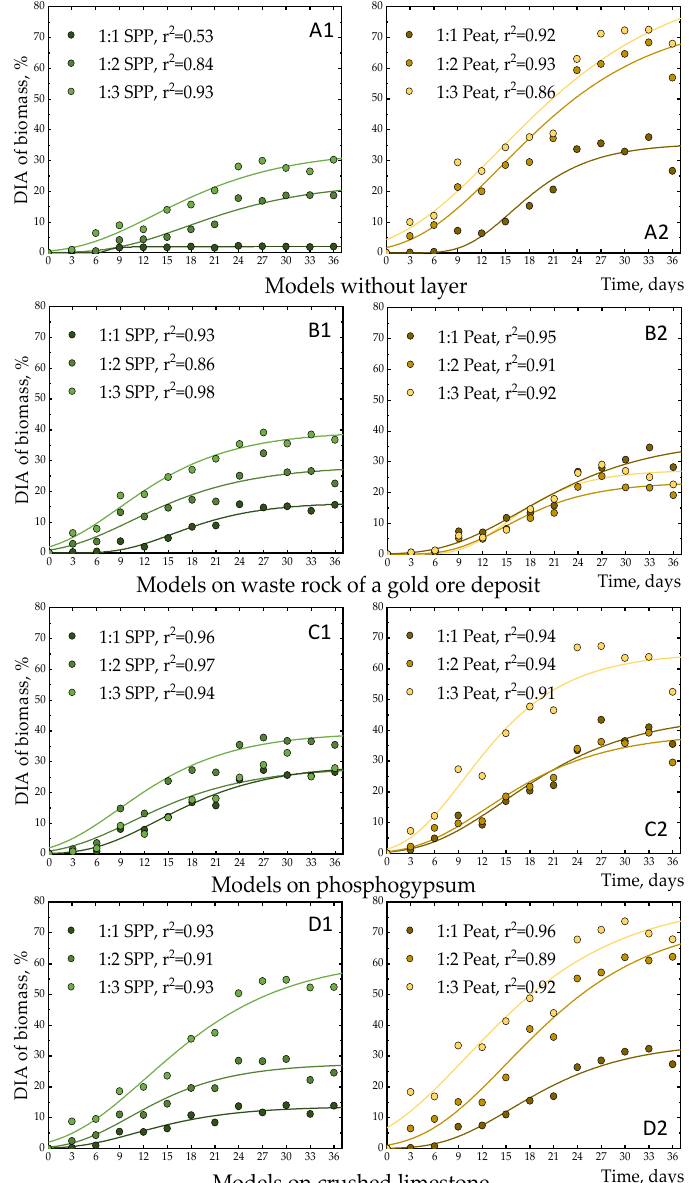
Figure 7. Rate of plant biomass growth by DIA and LAI (%): A—on the model without layer, B—on the waste rock of a gold ore deposit, C—on phosphogypsum, D—on crushed limestone, ( A1 , B1 , C1 , D1 )—on mixture of soil and wastewater sludge SPP, and ( A2 , B2 , C2 , D2 )—on mixture of soil and peat.